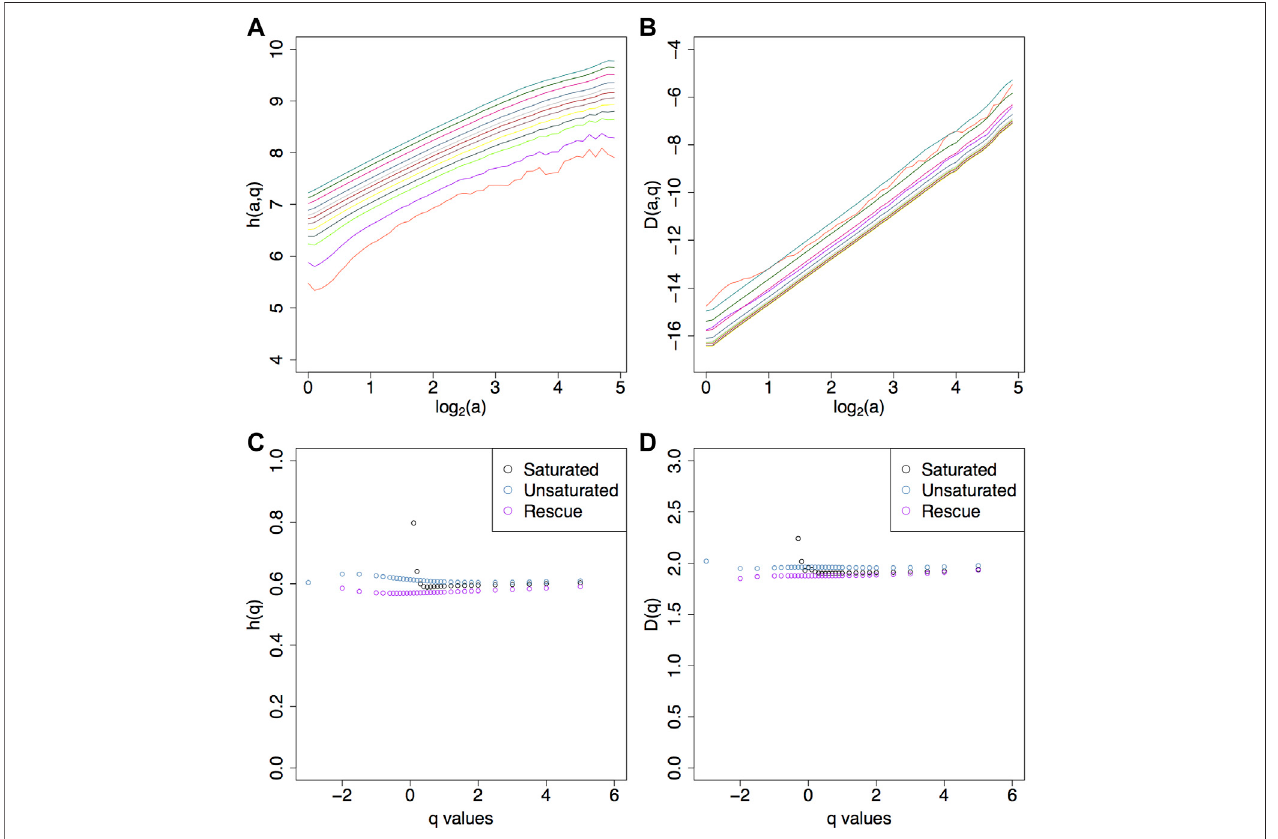
FIGURE 9 | Ef fi cacy of the rescue method. The h ( a , q ) (A) and D ( a , q ) (B) plots have better power law fi ts for a wider range of statistical order moments relative to their saturated counterparts. This expanded range of q values is re fl ected in the h ( q ) (C) and D ( q ) (D) plots. The saturated images had a q range 0.1 < q < 5 while the rescue method had − 2 ≤ q ≤ 5.